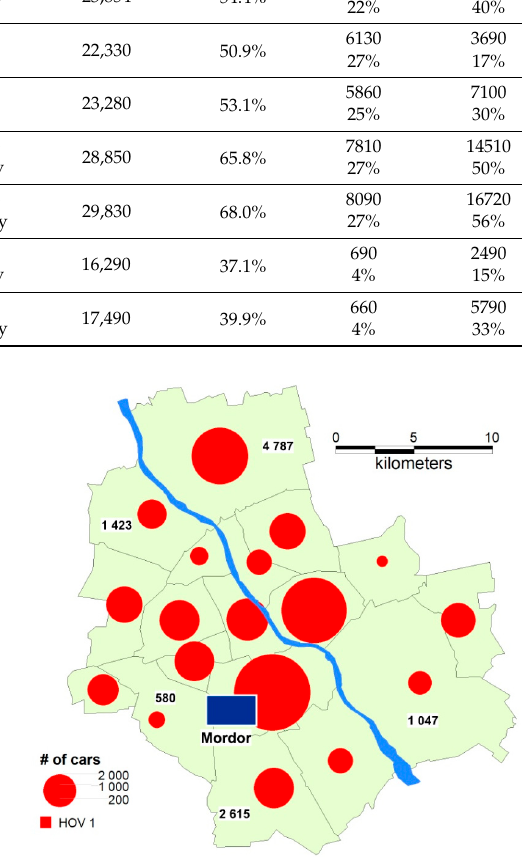
Figure 9. Reference data: the number of cars leaving particular districts of Warsaw for “Mordor” (every car is occupied solely by the driver).